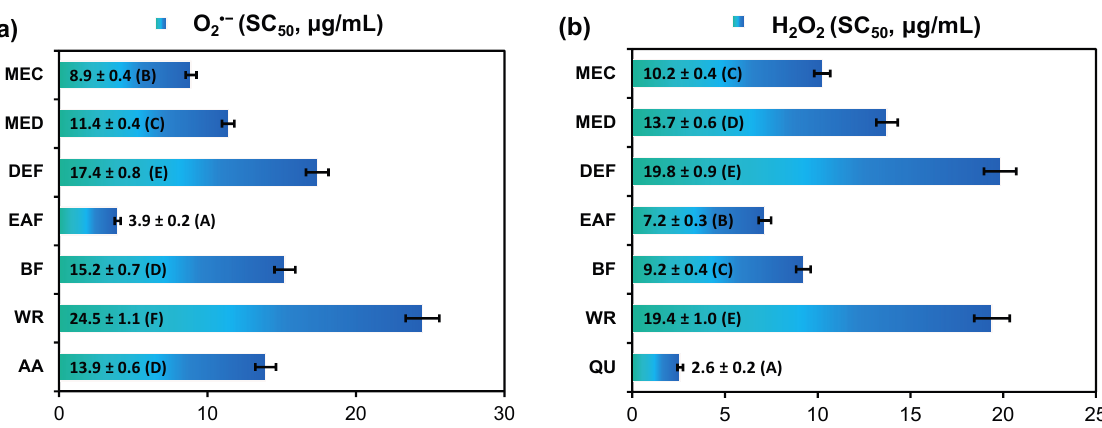
All data expressed as mean SC 50 values ± SD ( n = 3) represented by error bars. For each parameter different capital letters indicate significant differences ( p < 0.05). Scavenging efficiencies (SC 50 ), amounts of antioxidants needed to decrease the initial ROS concentration by 50% ( n = 3 × 1). Extract codes are given in Figure 1. Positive standards: AA, ascorbic acid; QU,